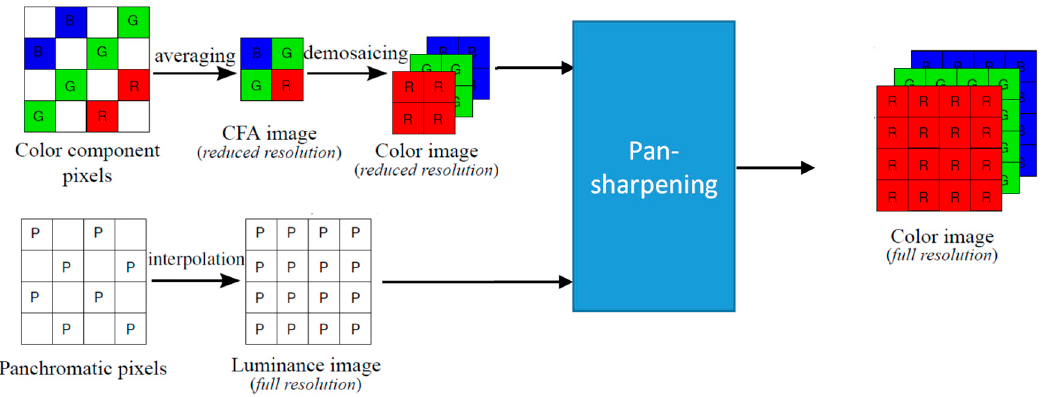
Figure 3. Pansharpening approach in